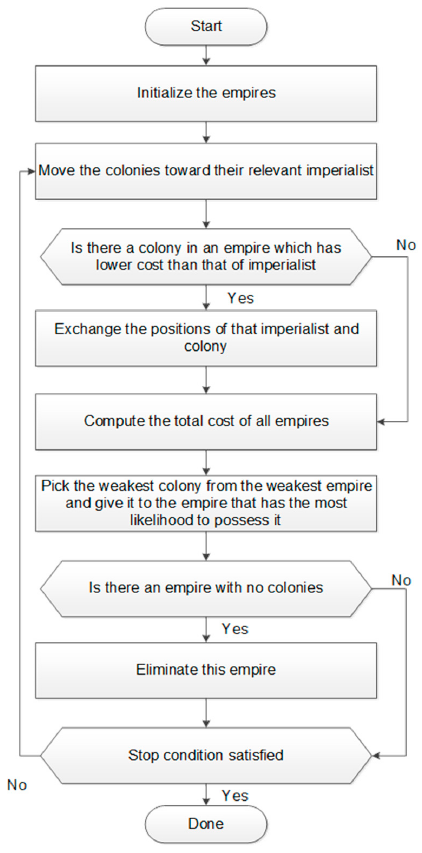
Figure 1. Imperialist competitive algorithm flowchart.